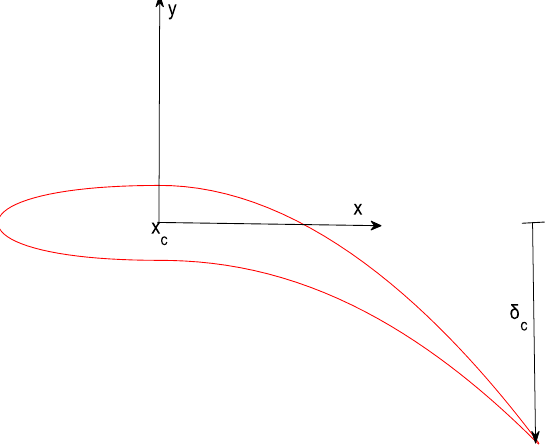
Figure 2. Trailing edge deformation model.